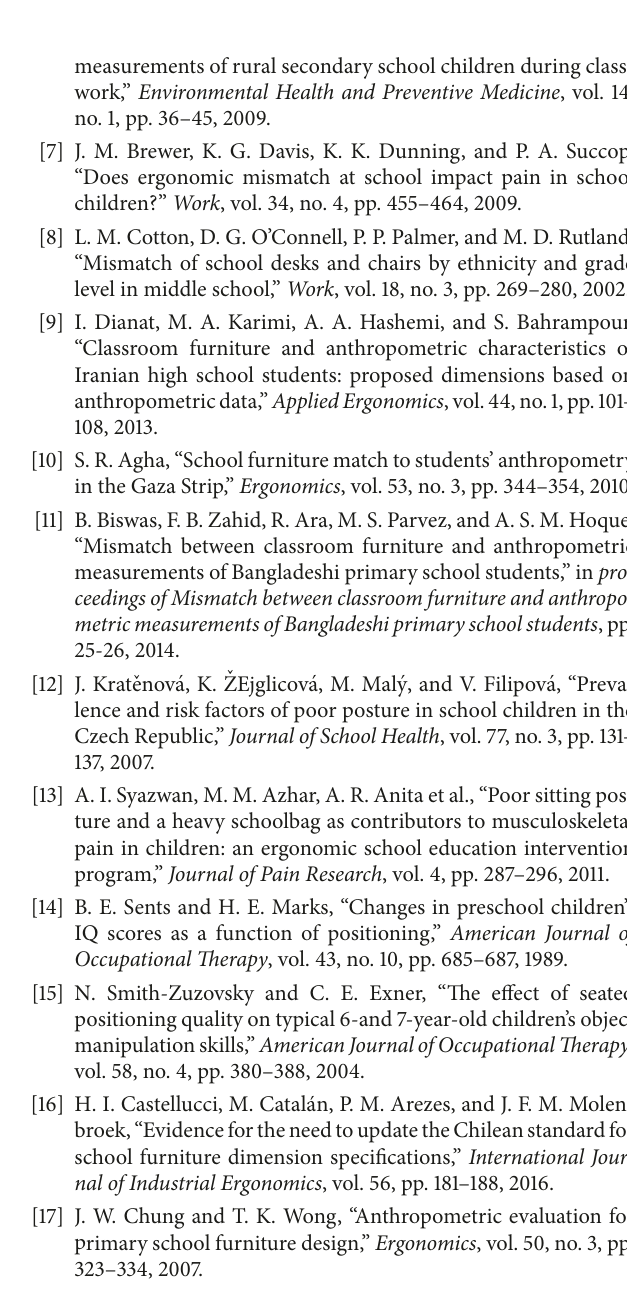
measurements of rural secondary school children during class-